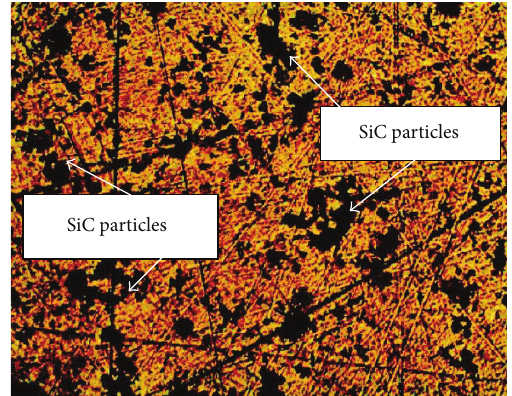
Figure 2: Optical microstructure with 20–40 𝜇 m SiC p at 400x.